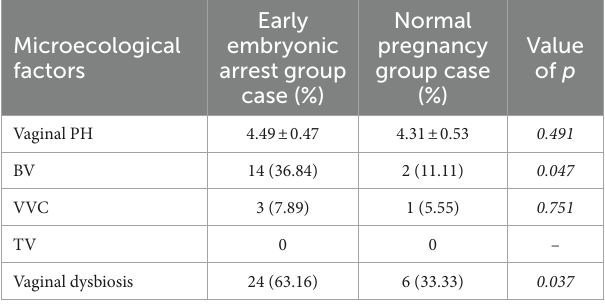
TABLE 2 Analysis of vaginal microecology in the early embryo arrest and normal pregnancy